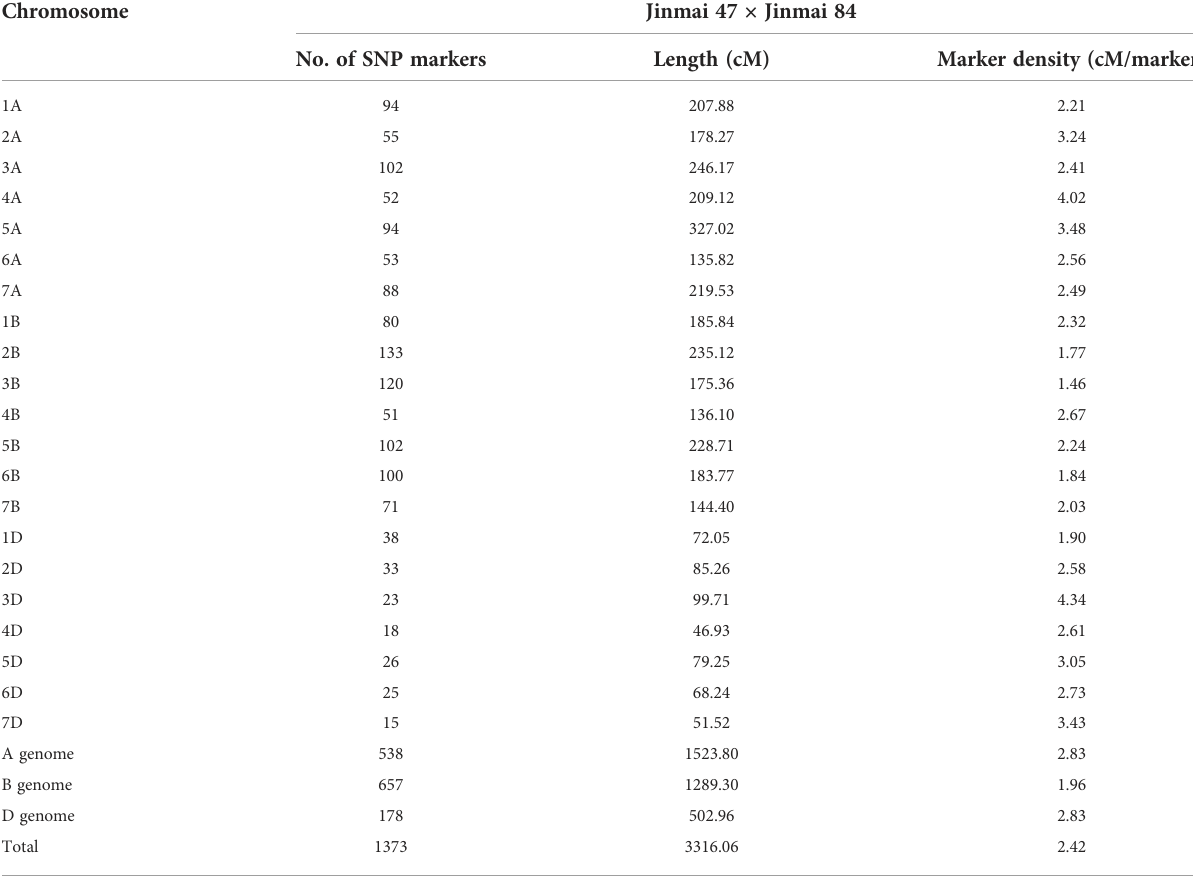
TABLE 3 Summary of linkage group and marker statistics obtained from a 15K SNP panel analysis of the DH1 population (Jinmai 47 × Jinmai 84). Chromosome Jinmai 47 × Jinmai